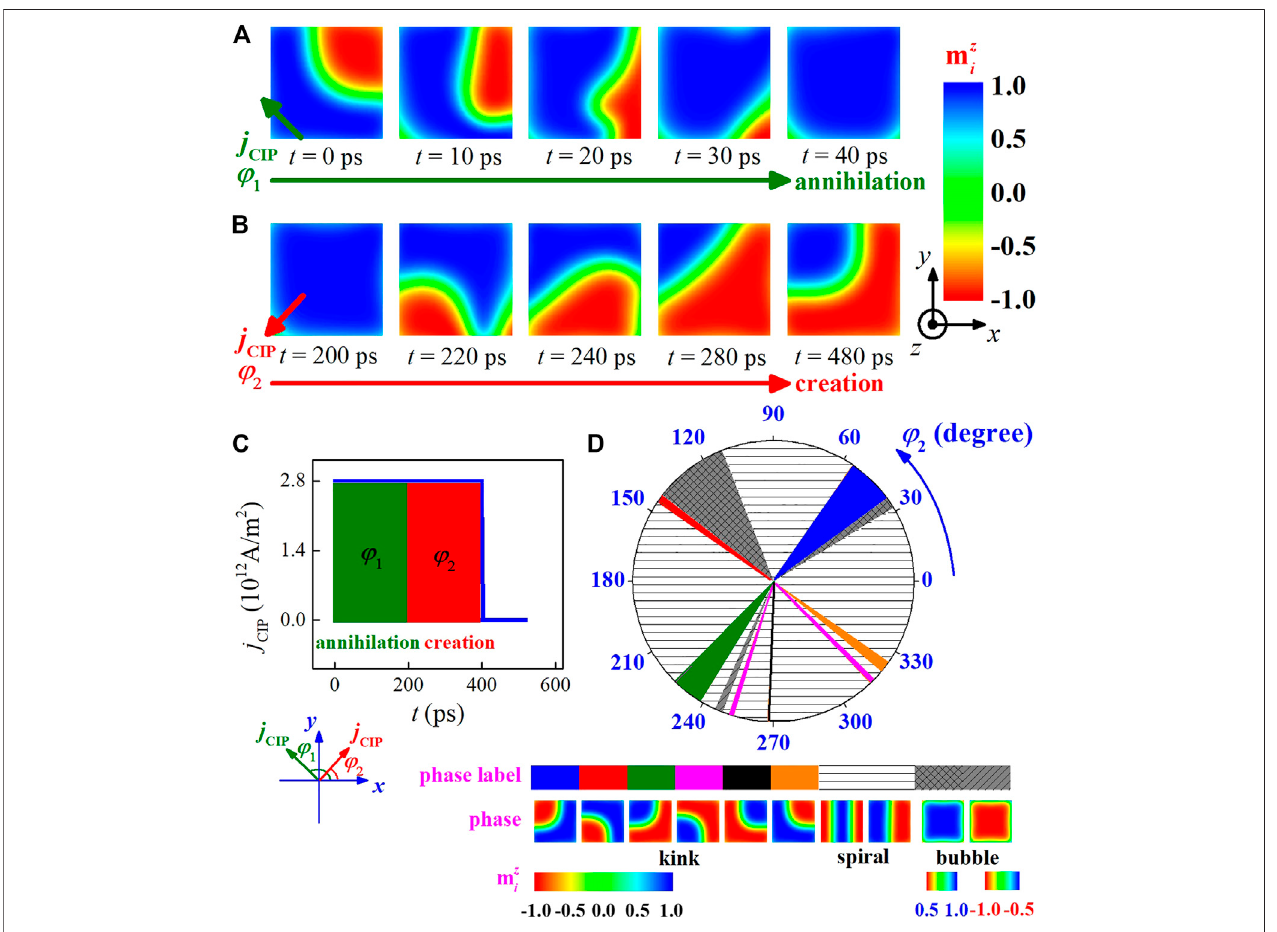
FIGURE 5 | The annihilation and creation of kink is achieved by applying CIP current pulses. (A) and (B) Snapshots show a typical case for the annihilation and creation process of kink induced by two successional current pulses with injection angle φ 1 (cid:2) 135 ° and φ 2 (cid:2) 230 ° . Simulations start from the initial UR kink state with p (cid:2) − 1. (C) Here two successional current pulses with injection angle φ 1 (cid:2) 135 ° and tunable injection angle φ 2 , current density j CIP (cid:2) 2.8 × 10 12 Am − 2 and duration t dur (cid:2) 20ps is considered. These two pulses are used to annihilate and create the kink state, respectively. (D) The phase diagram for the equilibrated states at t (cid:2) 520psafterrelaxationasafunctionofangle φ 2 wassummarized.Thevariouskinks,spiralstates,andbubblestatesaremarkedbythecoloredpieces,stripedpattern and grid pattern, respectively. The color map below is used to scale the magnetization components along z -axis m z i . Here the pie chart is generated from a set of data points for